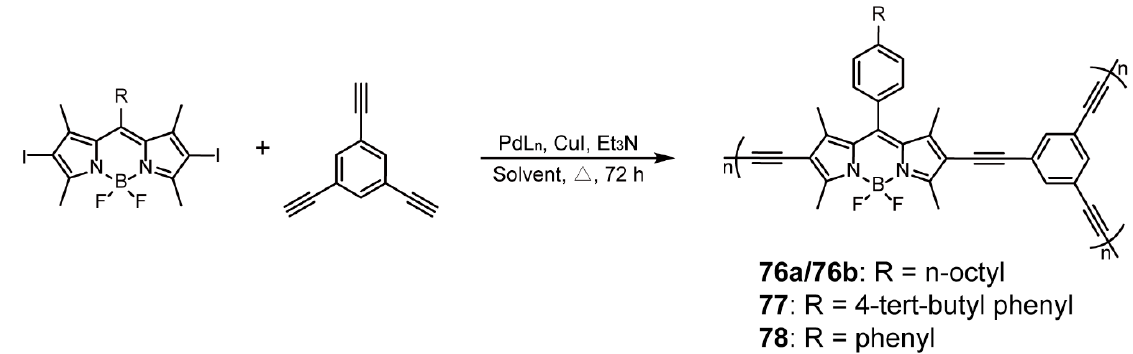
Figure 26. Synthesis of polymers 76–78 . (Reaction conditions: 76a: [Pd(PPh 3 ) 2 Cl 2 ], toluene, 80 °C; 76b : [Pd(PPh 3 ) 4 ], dimethylformamide, 130 °C; 77 : M2 monomer, [Pd(PPh 3 ) 4 ], DMF, 130 °C; 78 : M3 monomer, [Pd(PPh 3 ) 4 ], DMF, 130 °C) (Reproduced with permission from Reference [103]. Copyright @ 2016, American Chemical Society).